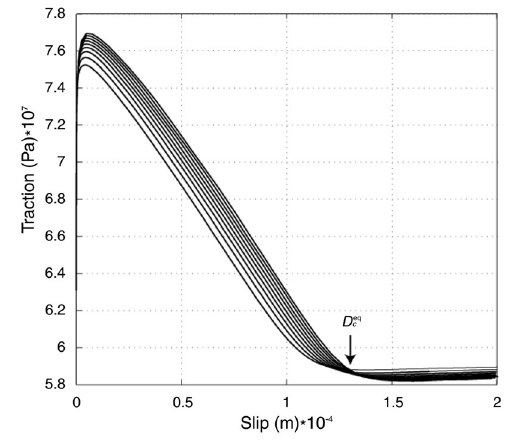
Fig. 3. Slip-weakening curves calculated for the reference model shown in the previous figures and listed in table II. The different traction evolutions as a function of slip have been plotted for different points located at different distances from the nucle- ation